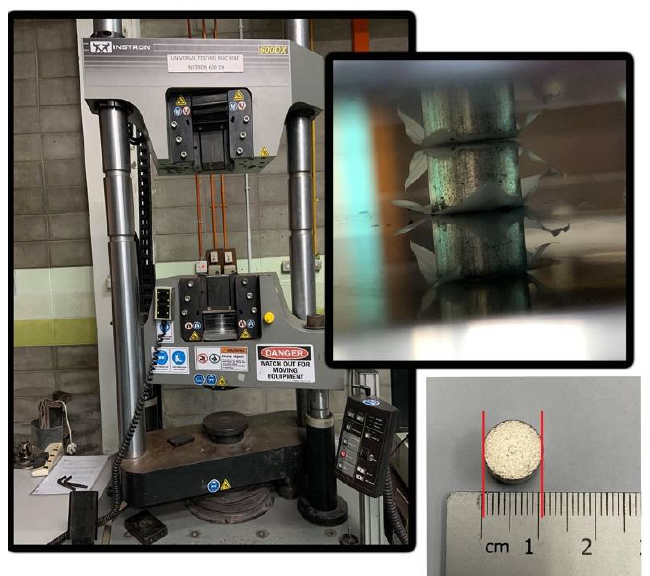
Figure 1. The model of Instron used throughout this study and the specimens were placed on the lower plate of device, which gradually compressed upward. The diameter of each specimen is 10 mm.